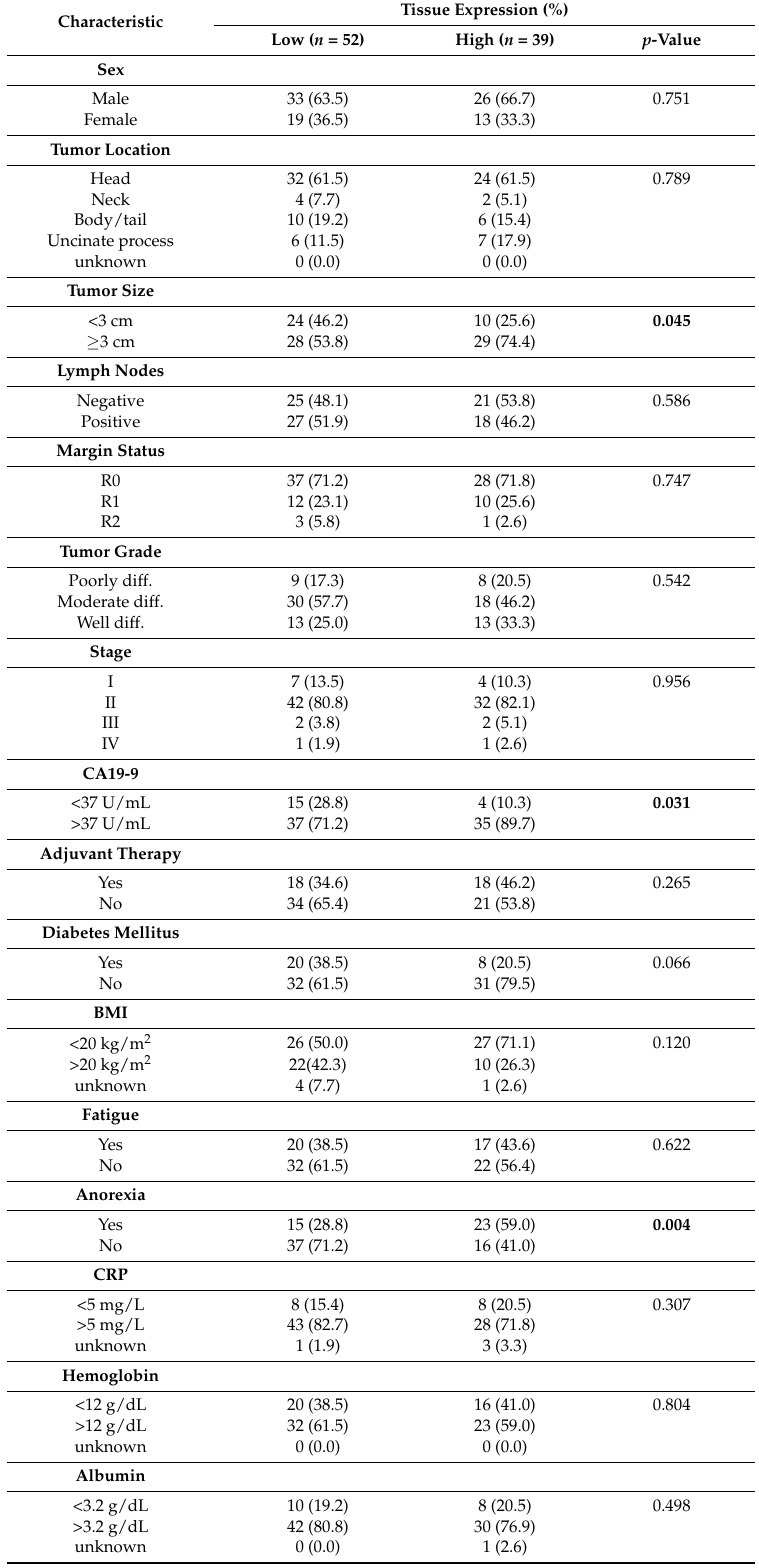
Table 2. The clinicopathologic characteristics and expression of IL-8 in pancreatic tumor